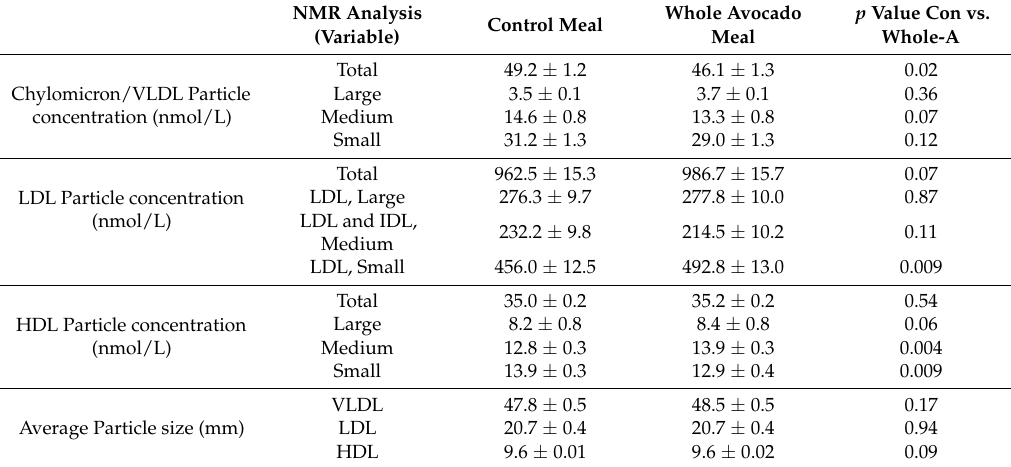
Table 4. Effect of breakfast meals on lipoprotein variables by nuclear magnetic resonance, NMR * ,† .